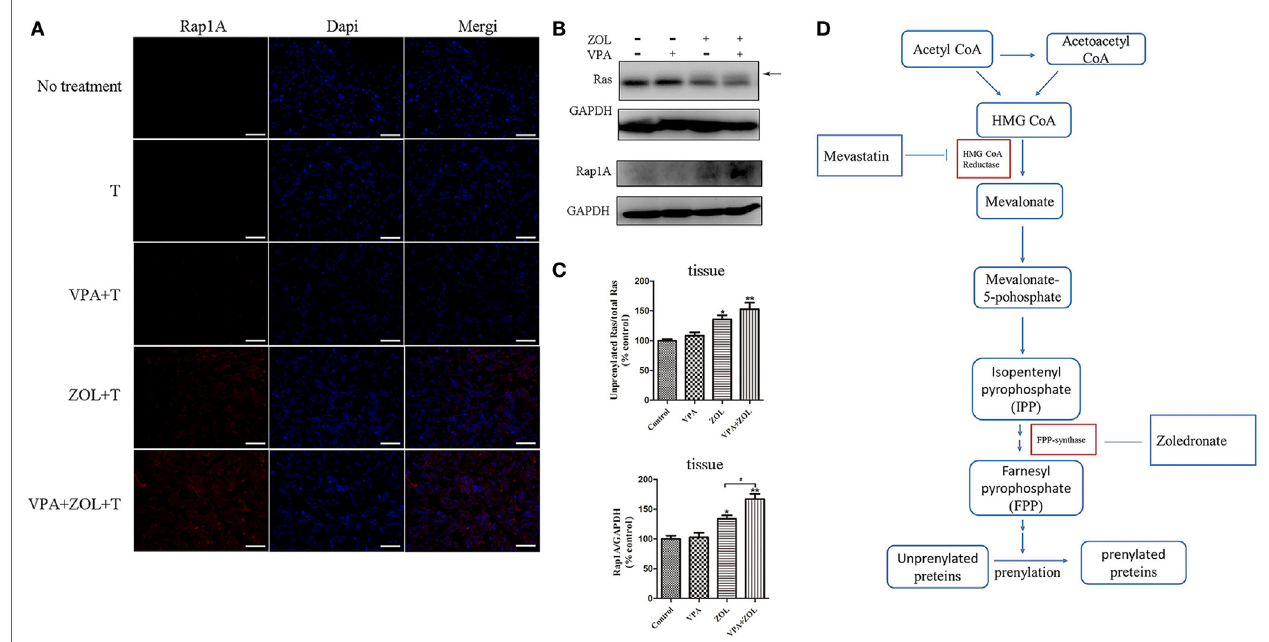
FigUre 5 | Inhibition of protein prenylation by in vivo treatment on osteosarcoma. Mice in different groups were sacrificed on 21th day after 2-week treatments and tumors were dissected. The expression levels of unprenylated proteins were detected by immunofluorescence and western blot. (a) The level of unprenylated Rap1A (red) was determined by fluorescence microscopy. The nuclei were counterstained with DAPI (blue). Scale bar: 50 µm. (B,c) The levels of unprenylated Rap1A and Ras were measured by western blot. The band marked by arrow corresponded to unprenylated form of Ras and the Rap1A antibody detected unprenylated form Rap1A. (D) Mevalonate pathway blockade induced by zoledronate (ZOL). The levels of unprenyalted proteins were normalized and the relative values were presented in histograms as mean ± SD; * p < 0.05, ** p < 0.01 versus control, # p <